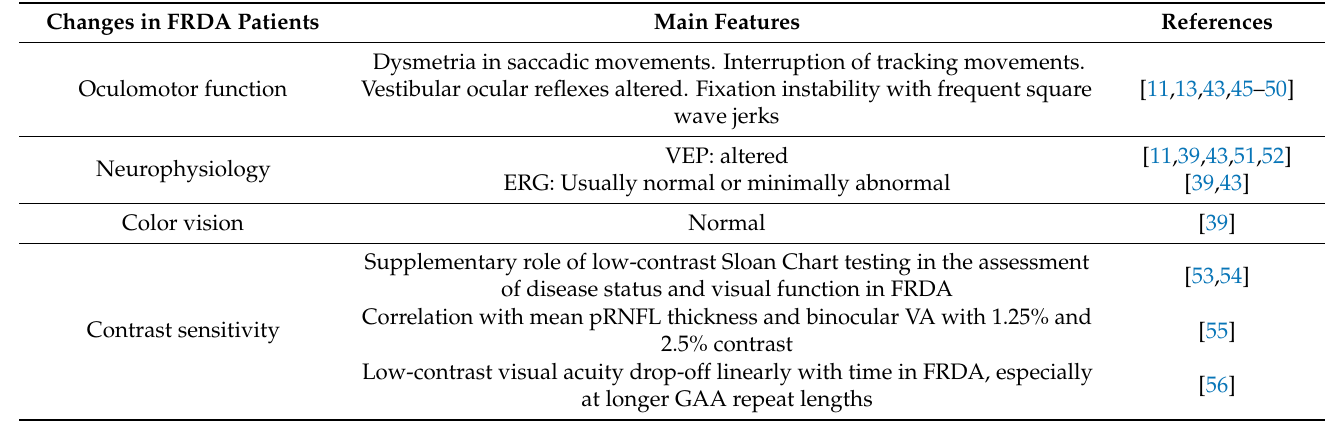
Table 2. Neuro-ophthalmological findings in FRDA.